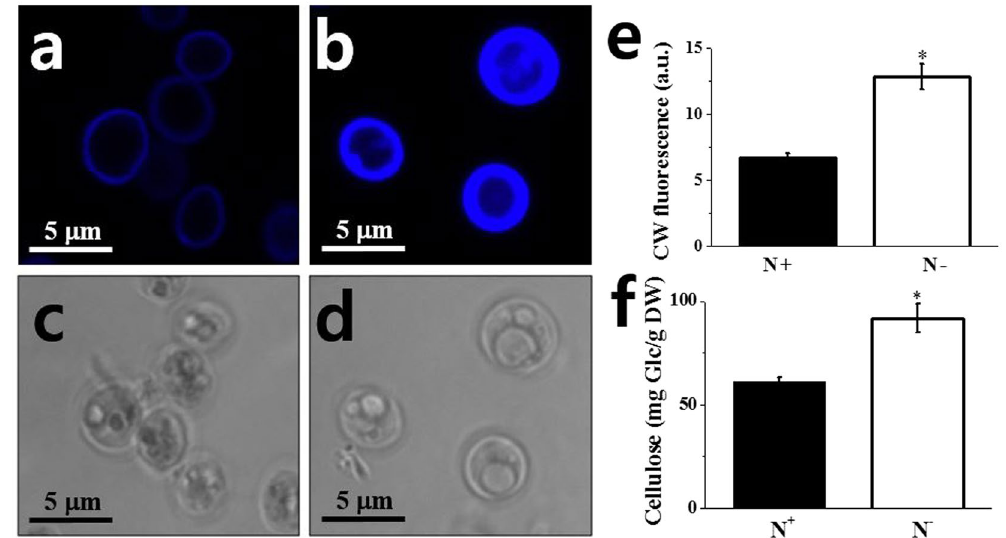
Figure 4. Representative images of calcofluor white (CW) fluorescence ( a , b ), and bright field ( c , g ), and quantification of CW fluorescence intensity ( e ) and cellulose ( f ) of N. salina cells grown under N + and N − conditions for 2 days. In ( f ), glucose (Glc) released from cell wall extracts by cellulase (1%, w/w) treatment for 24 h were quantified. Each data point represents the mean ± SE of three biological and technical triplicate culture